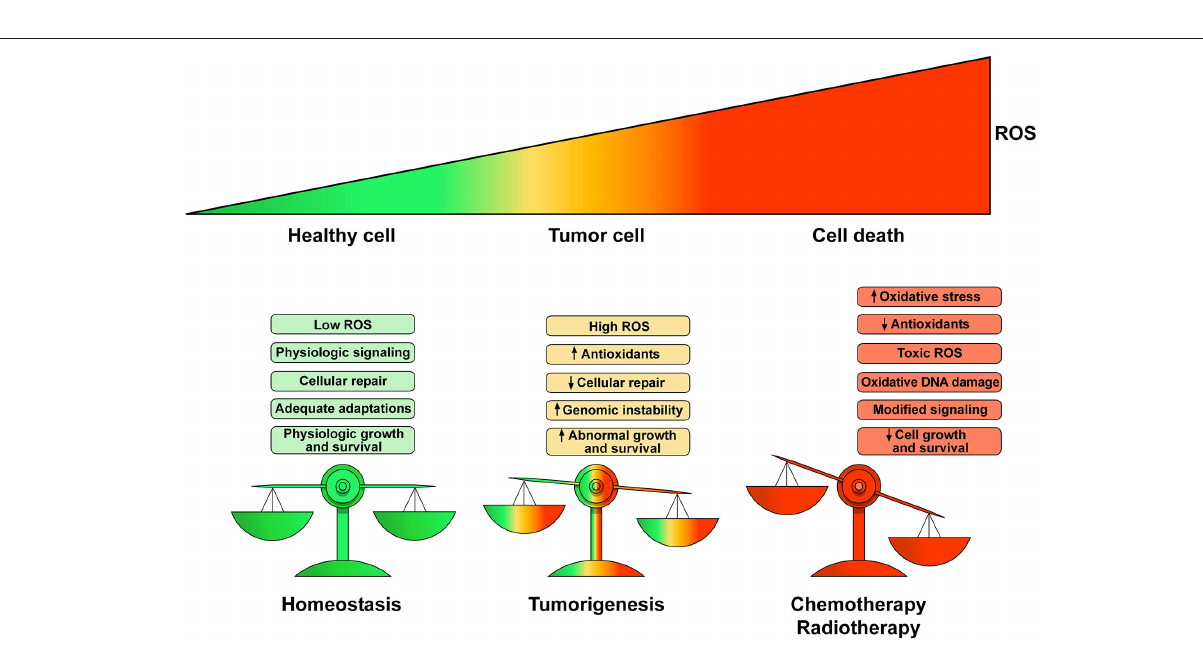
Frontiers in Physiology | www.frontiersin.org